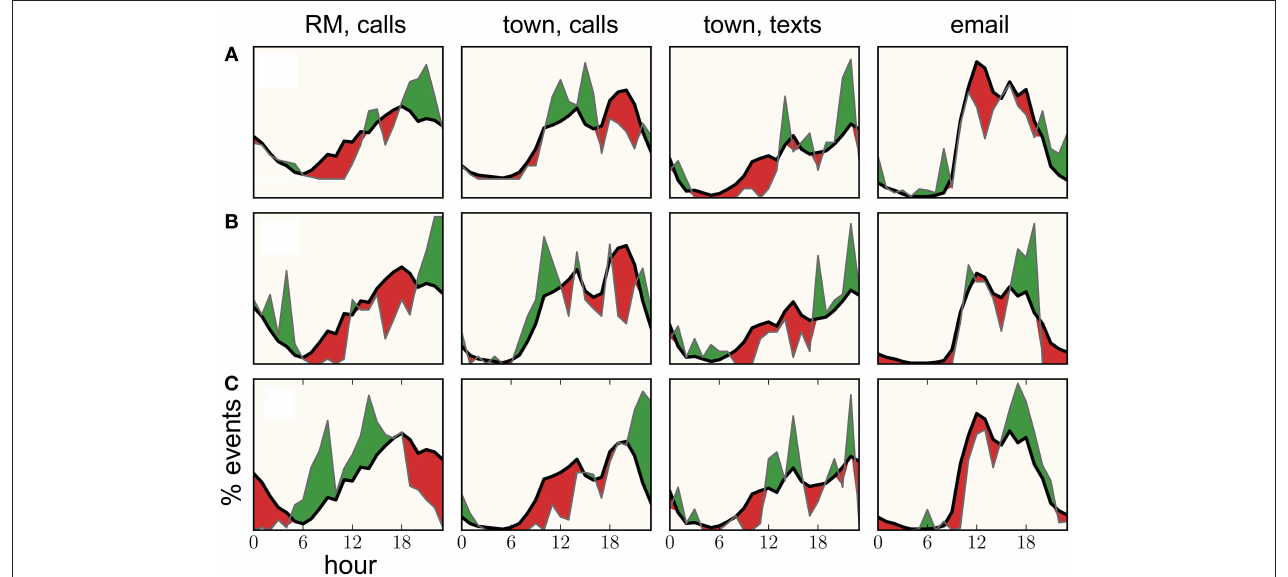
FIGURE 3 | A sample of 12 individual-level daily patterns for four datasets to illustrate the diverse nature of individual patterns. Columns correspond to datasets, while rows (A–C) correspond to different individuals (who are not the same across datasets). The black line shows the average daily pattern for the dataset in question—and therefore is the same in each column—whereas green/red areas denote where this individual’s pattern is above or below average. We observe that in almost every case, the individual patterns differ strongly from the average behavior, for example by increased calling frequency during mornings, mid-days, or